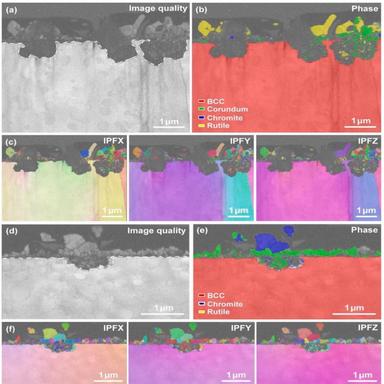
The on-axis TKD maps of the oxide scales of the Al12 and Al16 CCAs after 100 h oxidation at 800 ◦C in air: (a) Image quality image, (b) Phase image, (c) IPFX, IPFY, and IPFZ images of Al12 CCA; (d) Image quality image, (e) Phase image, (f) IPFX, IPFY, and IPFZ images of the Al16 CCA.